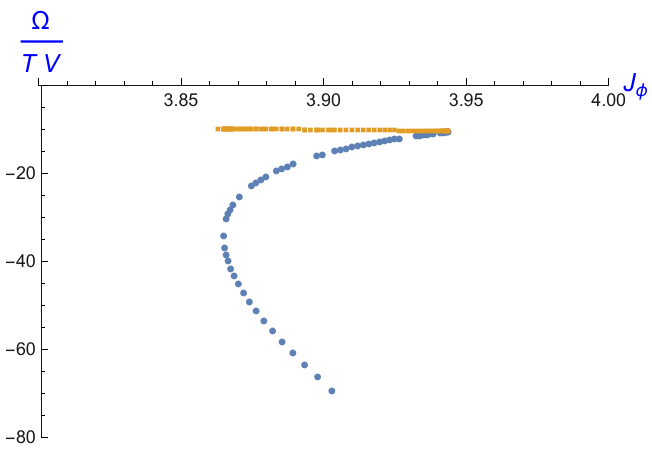
Figure 5. Here we plot the di(cid:11)erence in free energies of the two solutions, at (cid:11) 1 = 0 : 1 = (cid:11) 2 , (cid:12) = 0 and (cid:21) = 0 : 66. The orange line represents the normal phase, while the blue line represents the superconducting